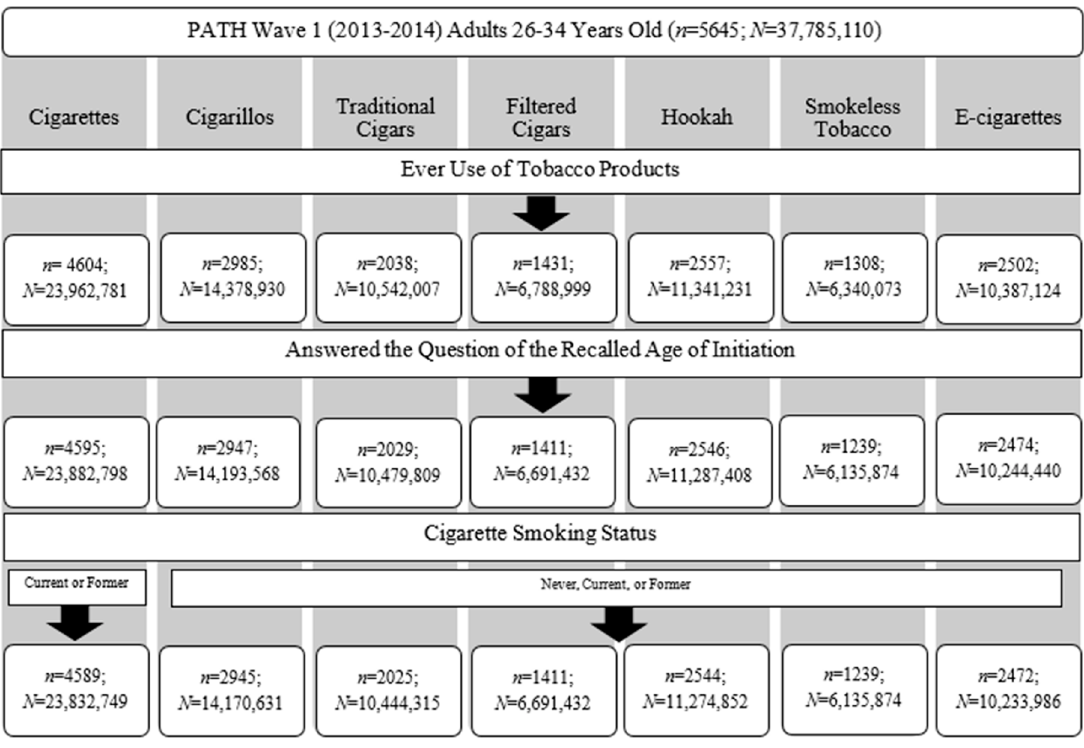
Figure 1. Flowchart depicting how the final sample sizes for each tobacco product (TP) were obtained for analyses. PATH: Population Assessment of Tobacco and Health.